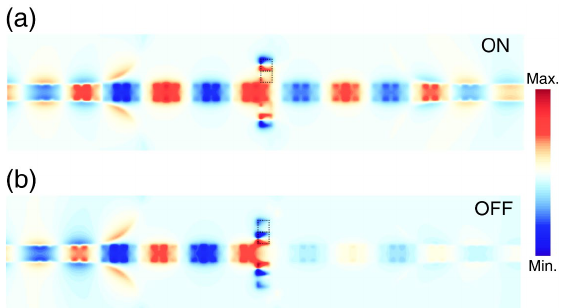
Figure 3. Simulated near-electric-field distributions in the x–y plane at 1.5 mm above the entire structure at the EIT-like peak frequency of 5.42 GHz. The PIN diodes are in ( a ) ‘ON’ state ( R d = 0.9 Ω, L d = 1.5 nH), and ( b ) ‘OFF’ state ( C d = 0.3 pF, L d = 1.5 nH), respectively. The dotted regions near the SSPP waveguide mark the locations of passive SRR and active SRR, respectively. 3. Measurement and Discussion To perform experimental verification of the aforementioned functions, samples of a corrugated SSPP waveguide loaded with a single set of passive SRRs, active SRRs, and EIT modules were fabricated using the standard printed circuit board (PCB) technology,